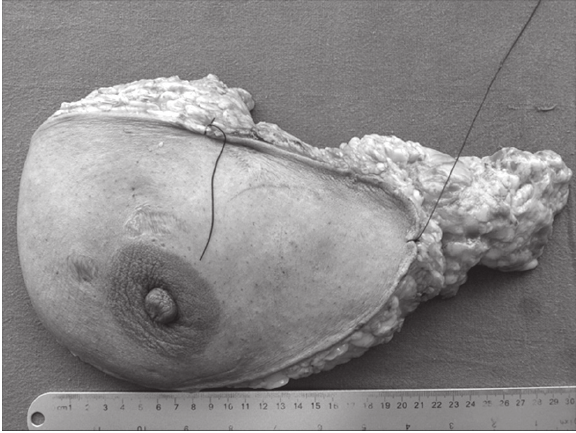
Figure 1: Modified Radical Mastectomy